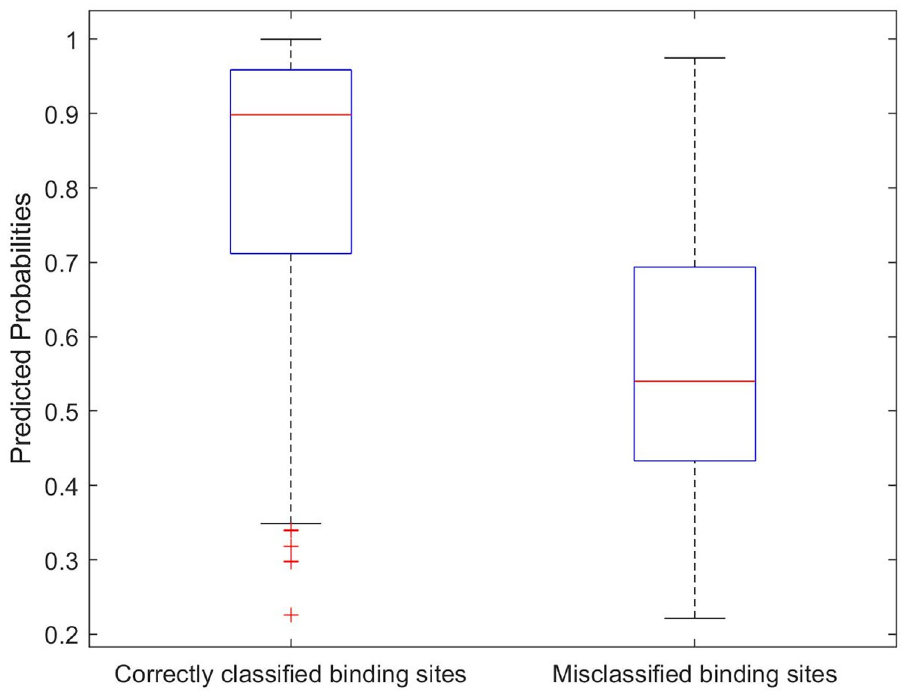
Fig 7. Correctly classified and misclassified binding sites vs their predicted probabilities. A comparative boxplots of the distributions of the predicted probabilities.